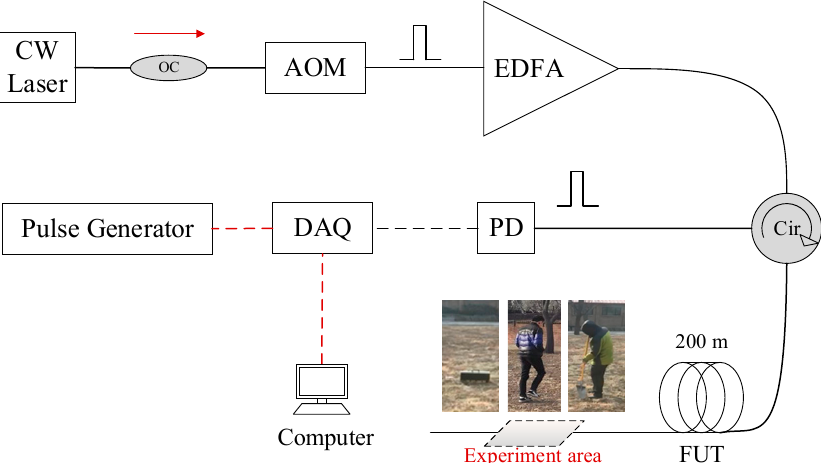
Figure 8. Schematic diagram of the Φ -OTDR system. CW: Continuous Wave, OC: Optical Coupler,